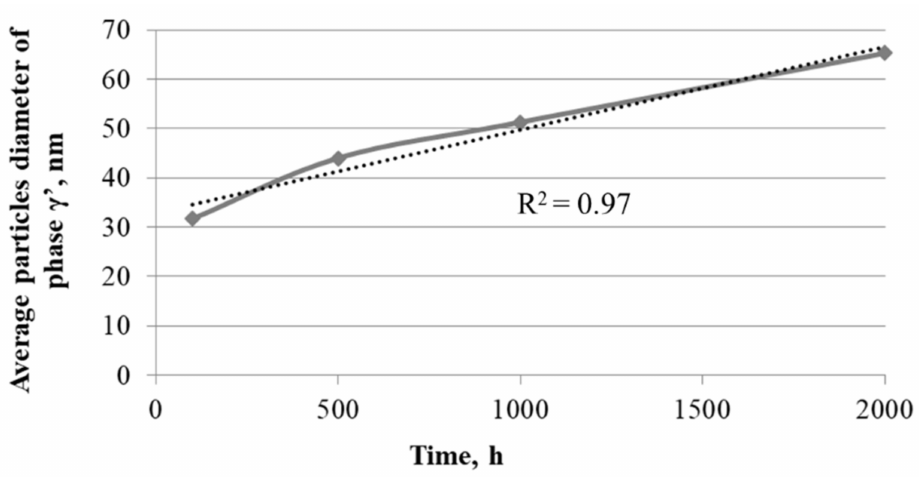
Figure 3. Effect of the heating time during oxidation at 750 ◦ C on value of average particles’ diameter of γ (cid:48) phase.